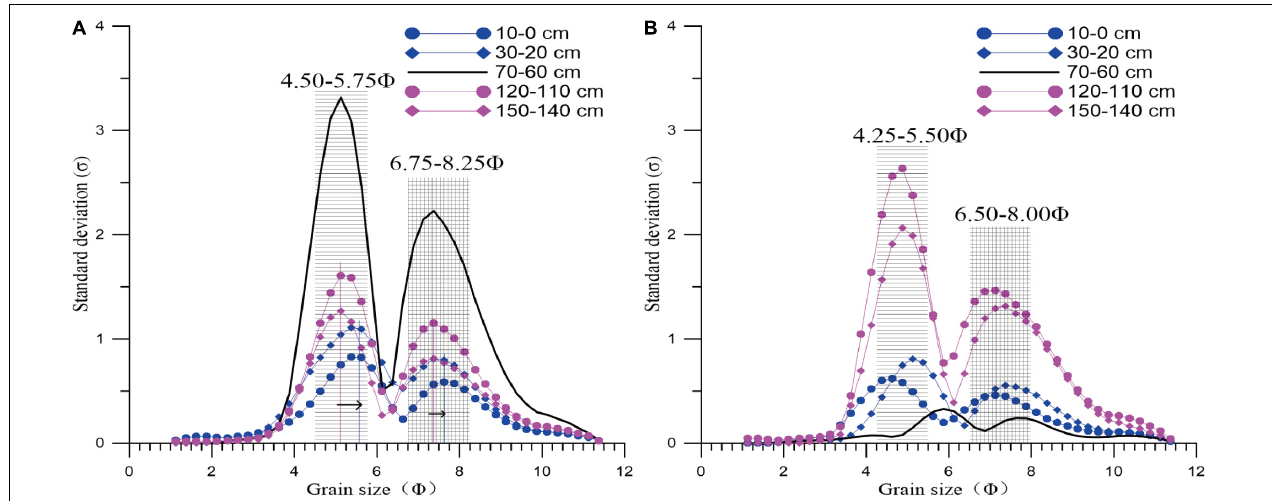
FIGURE 5 | Sensitive grain size fractions of core Z7 (A) and Z8 (B) of the selected layer were as follows: the sensitive grain size of Z7 was relatively finer than that of Z8; the sensitive grain size fraction of Z7 tended to be finer after 1977, and Z8 had no obvious tendency. The black horizontal arrows indicate that the sensitive grain size has become finer after 1977.